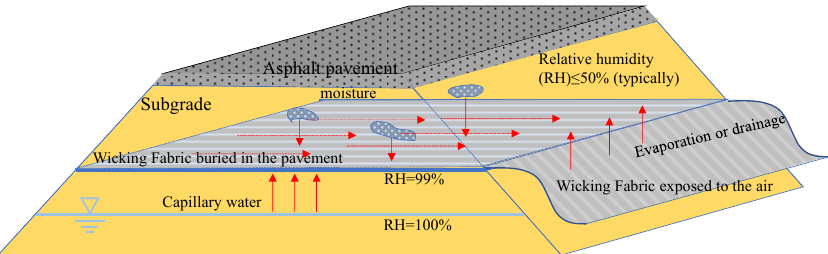
Figure 1. Mechanisms of water removal by WF in a pavement system.